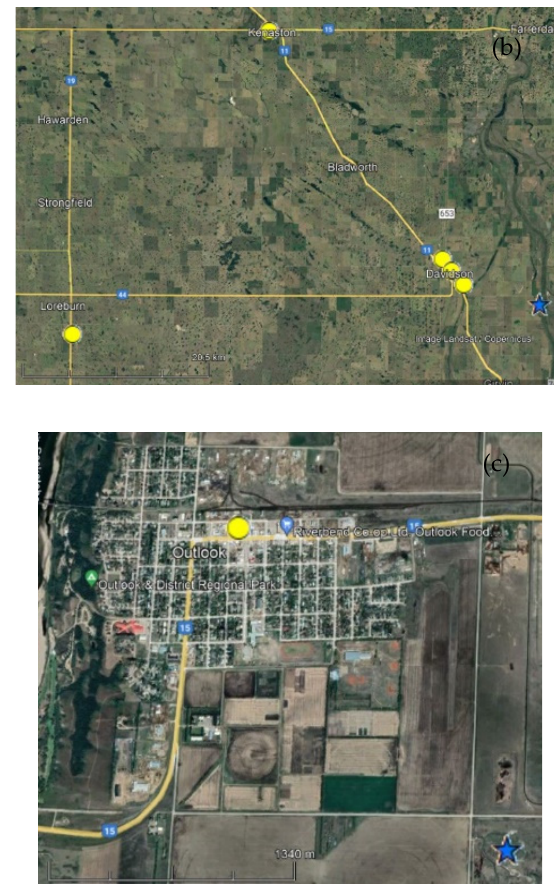
Figure 4. Populated points and active landfills in ( a ) PIDS 1 ( b ) PIDS 3 and ( c ) PIDS 4. The blue stars represent the active landfills, and the yellow circles represent the major populated points. Map source: [77].